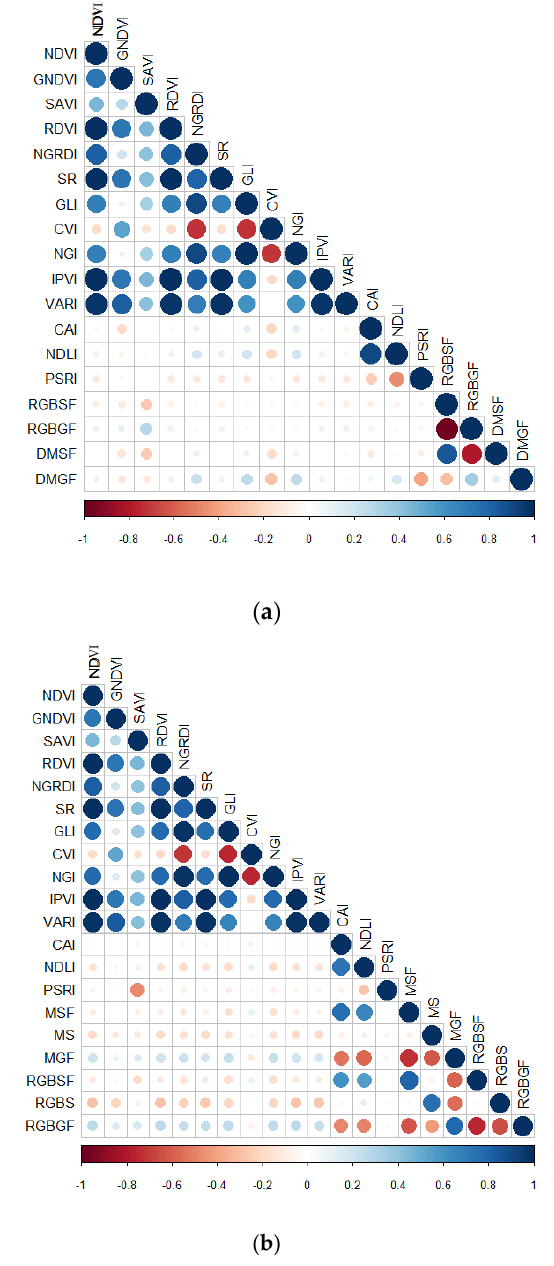
Figure 5. The correlogram for ground cover fractions and vegetation indices; plot ( a ) shows the preharvest data and plot ( b ) represents the postharvest data. Positive correlations are displayed in blue and negative correlations in red color. Color intensity and the size of the circle are proportional to the correlation coefficients. MSF is manual senescent fraction, MGF is manual green fraction, MS is manual soil cover, RGBSF is RGB sensor-based senescent fraction, RGBGF is RGB sensor-based green fraction, and RGBS is RGB sensor-based soil cover. DMSF is the dry matter percentage of the senescent fraction, and DMGF is the dry matter percentage of the green fraction.